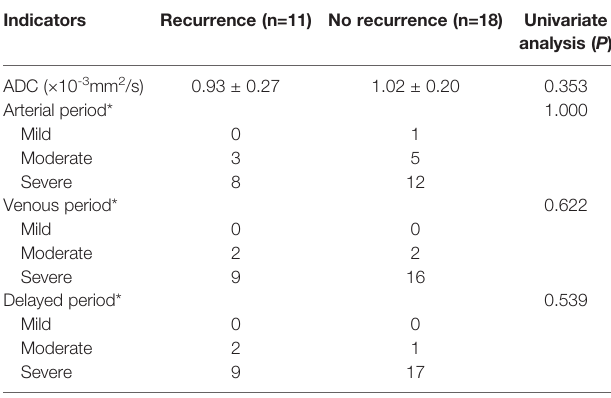
TABLE 2 | The statistical results of the univariate analysis of the ADC values and enhancement degrees of the recurrence and no recurrence groups.